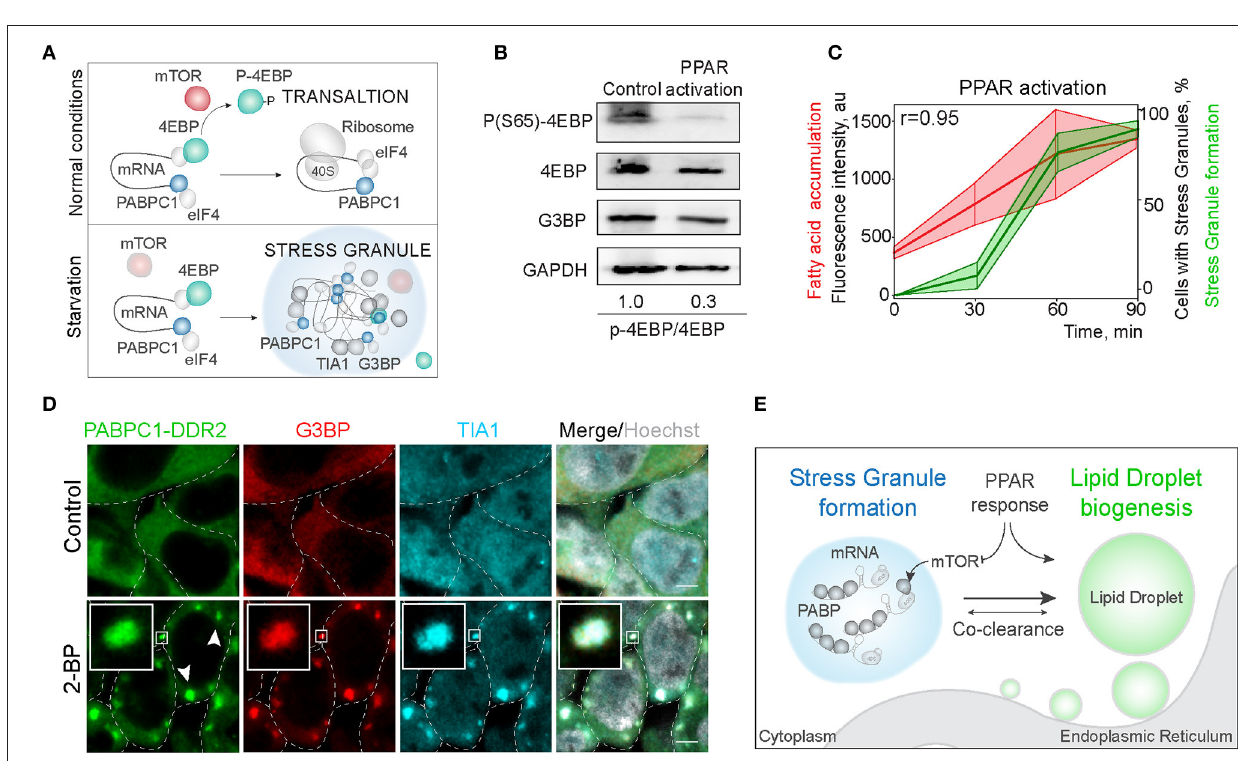
FIGURE 4 | Activation of LD formation triggers SGs. (A) Schematic of mTOR regulation of translation favoring SG formation. During normal conditions, mTOR phosphorylates 4EBP allowing translation initiation. Downregulation of mTOR results in translation inhibition and stress granule formation. (B) PPAR activation leads to mTOR inactivation. Cells were incubated with PPAR activators (rosiglitazone, clofibrate, and GW501516, 100 µ M) for 3h. mTOR activity was assessed by 4EBP phosphorylation (Ser65) state. Ratio of phosphorylated to non-phosphorylated 4EBP is shown (B) . (C) Quantification of SG formation and LD accumulation during PPAR activation (refer to Figure 1A ). Graph shows percentage of cells with SGs in the population and LD fluorescence intensity, mean ± SD. Pearson correlation coefficient ( r ) is 0.95. (D) Immunofluorescence showing SG markers localization to the inclusions. PABPC1-DDR2 cells were treated with 2-BP (200 µ M) for 1h. Cells were fixed and stained with anti-G3BP and anti-TIA1 antibodies. Confocal planes are shown; inlets show SGs; scale bar, 5 µ m. (D) Model of the joint regulation of SG and LD